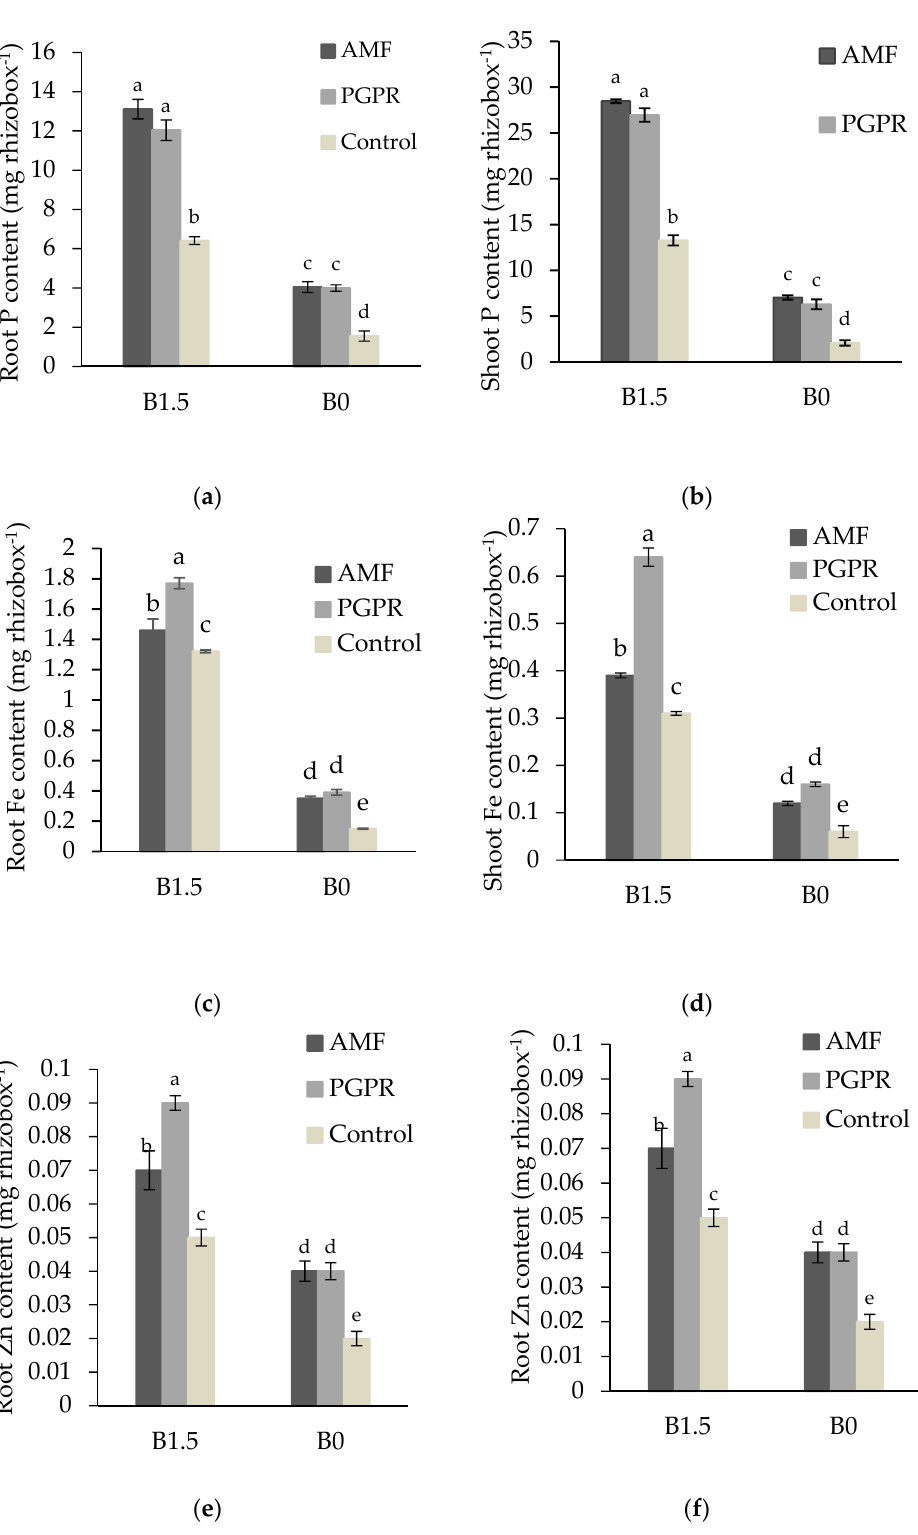
Figure 3. The effect of the organic source and microbial inoculation on the uptake of P ( a , b ), Fe ( c , d ), and Zn ( e , f ) in plants. Different letters indicate significantly different values at p ≤ 0.05. B1.5 and B0 are biochar 1.5% and no biochar, respectively.